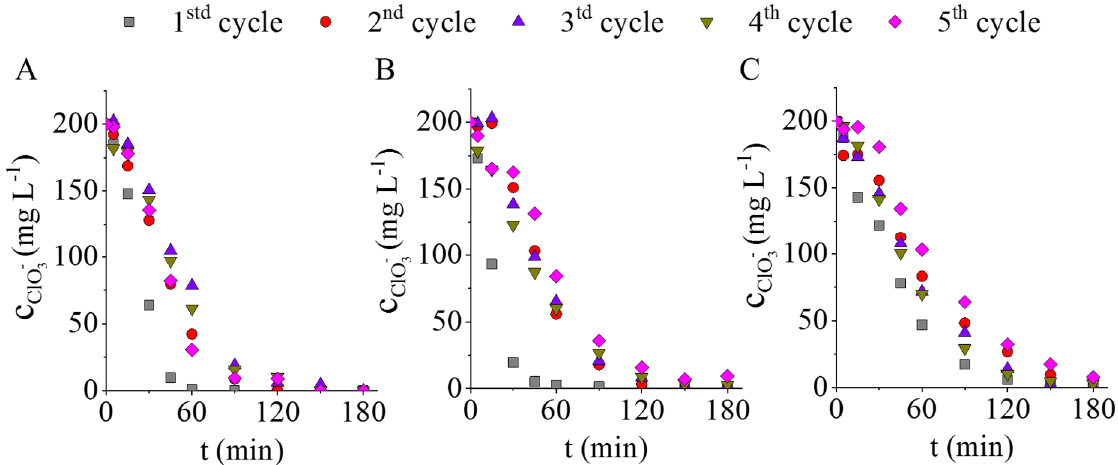
Figure 7. Decreasing chlorate concentration depending on the hydrogenation time by applying the developed catalysts over five cycles: Pd-Pt/Ni-GCNC ( A ), Pd-Pt/Fe-GCNC ( B ) and Pd-Pt/GCNC ( C ).